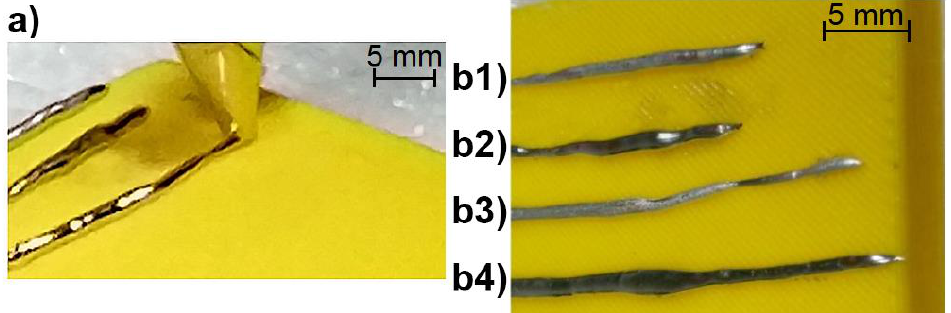
Figure 3. ( a ) Fabrication of conductive paths using a specially designed aluminum nozzle; Paths fabricated using: ( b1 ) hot air and Sn99Ag0.3Cu0.7; ( b2 ) hot air and Sn60Pb40; ( b3 ) hot iron and Sn99Ag0.3Cu0.7; ( b4 ) hot iron and